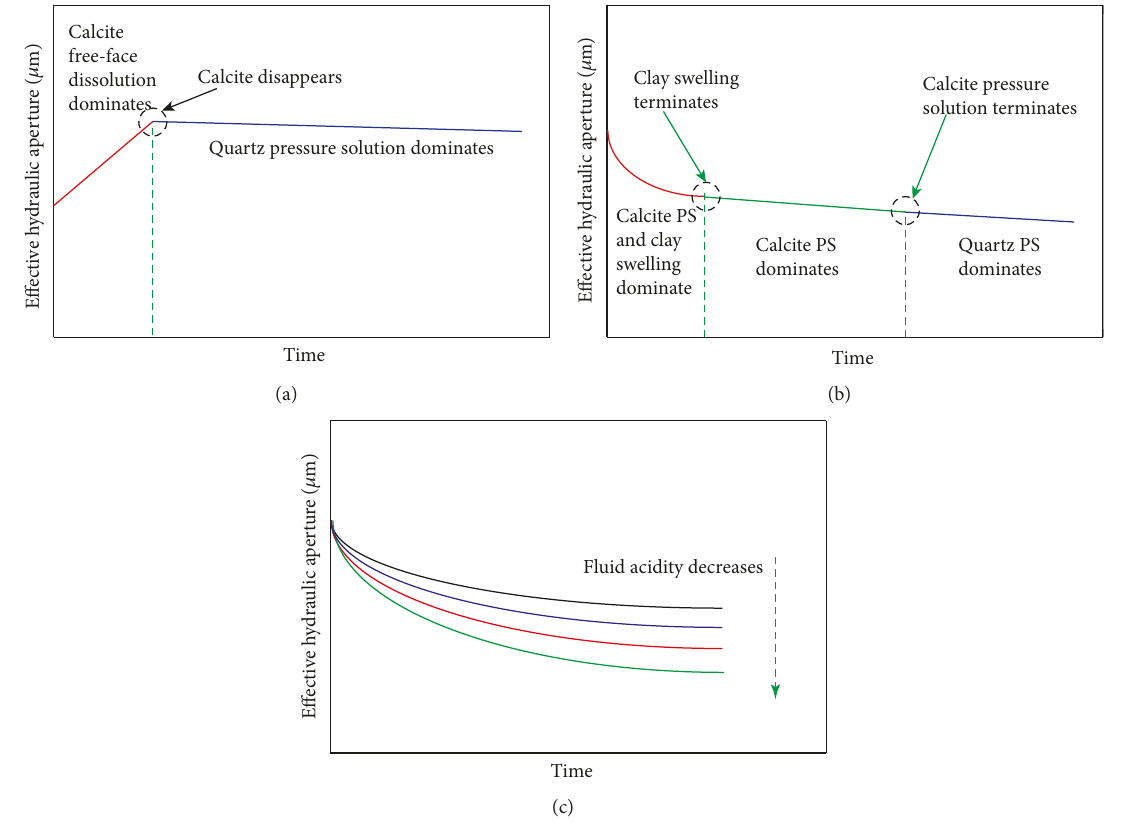
Figure 16: E ff ective hydraulic aperture evolution with time under various conditions in shale. (a) Shale with calcite under high fl uid acidity conditions, (b) shale with calcite under low fl uid acidity conditions, and (c) shale with high clay